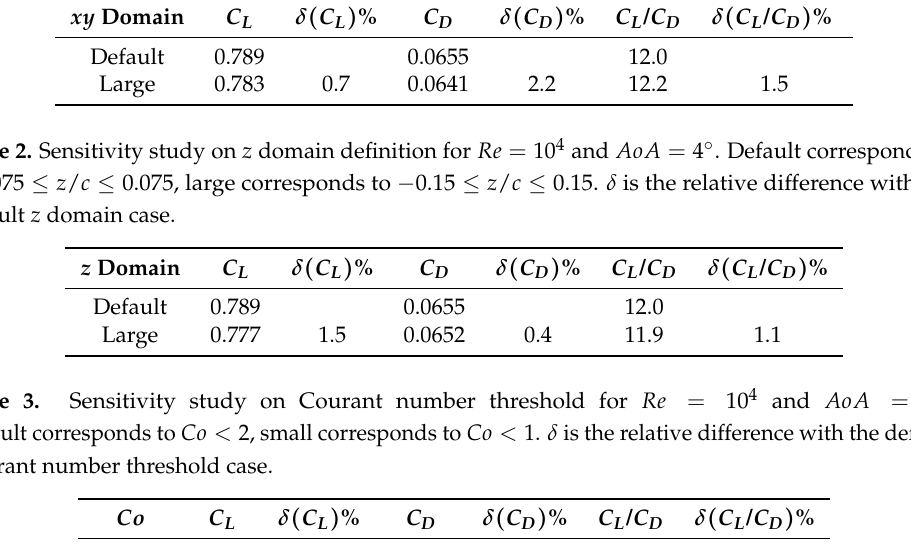
Table 1. Sensitivity study on xy domain definition for Re = 10 4 and AoA = 4 ◦ . Default corresponds to